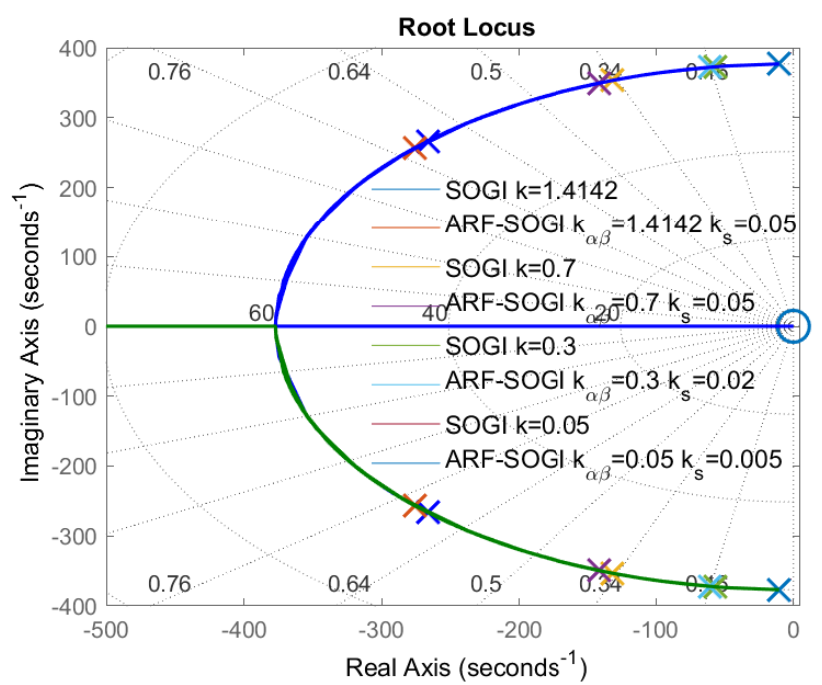
Figure 6. SOGI-QSG and ARF-SOGI-QSG band-pass filter v (cid:48)